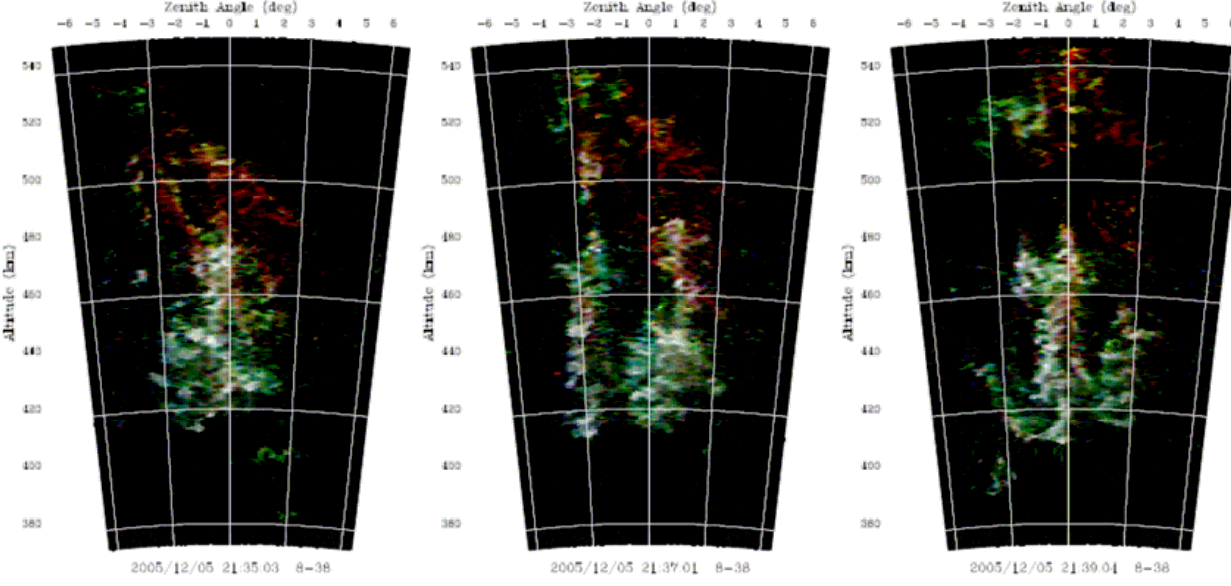
Fig. 17. Jicamarca interferometric image showing a Spread F plume. Notice the plume bifurcation and the rapid uplift of the red (negative Doppler shift) patch from one frame to the next (courtesy of D. L.